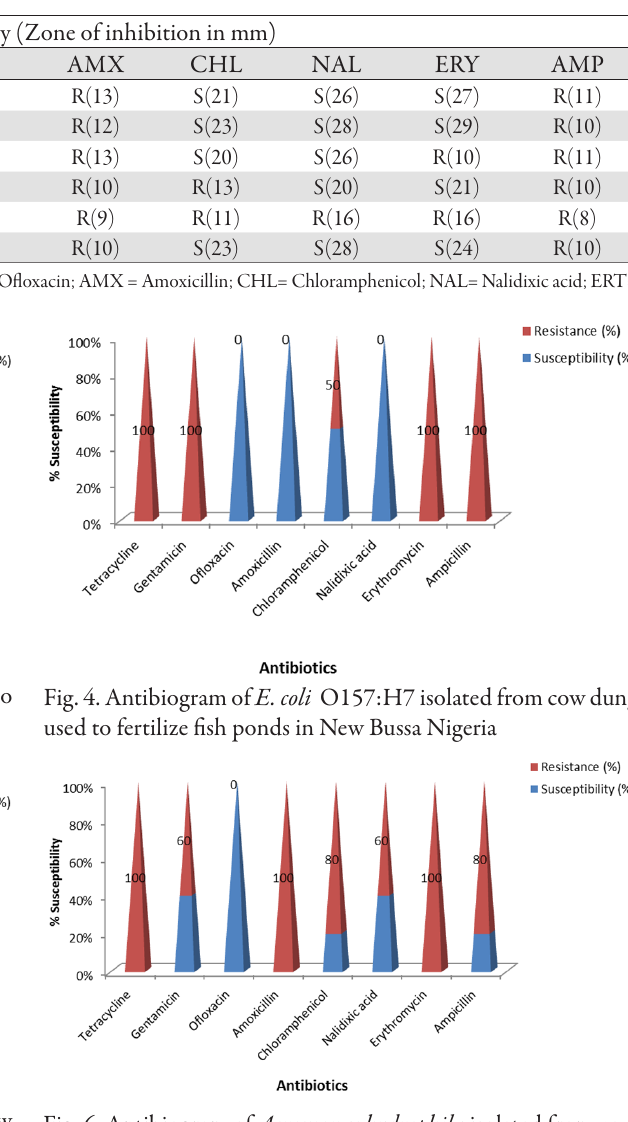
Fig. 6. Antibiogram of Aeromonas hydrophila isolated from cow dung used to fertilize fish ponds in New Bussa Nigeria